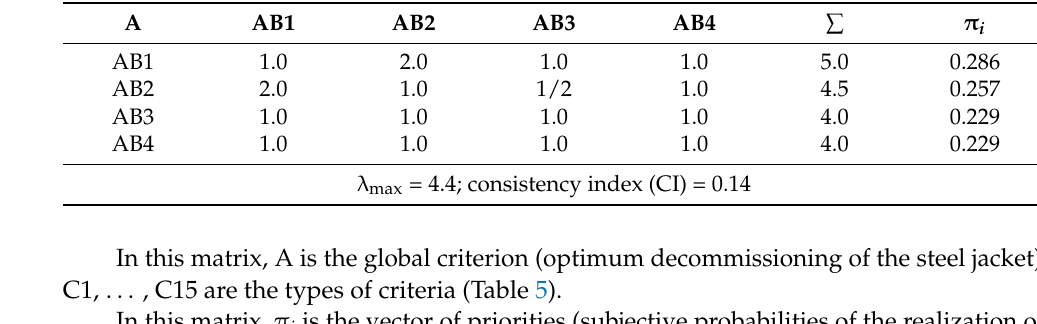
Figure 5. Hierarchical structure of selection of decommissioning options for offshore structures (platforms). (Source: designed by authors). The calculation scheme (AHP additive model), using developments [9–12] for our example, is below. Table 6. Matrix of pairwise comparisons (Level